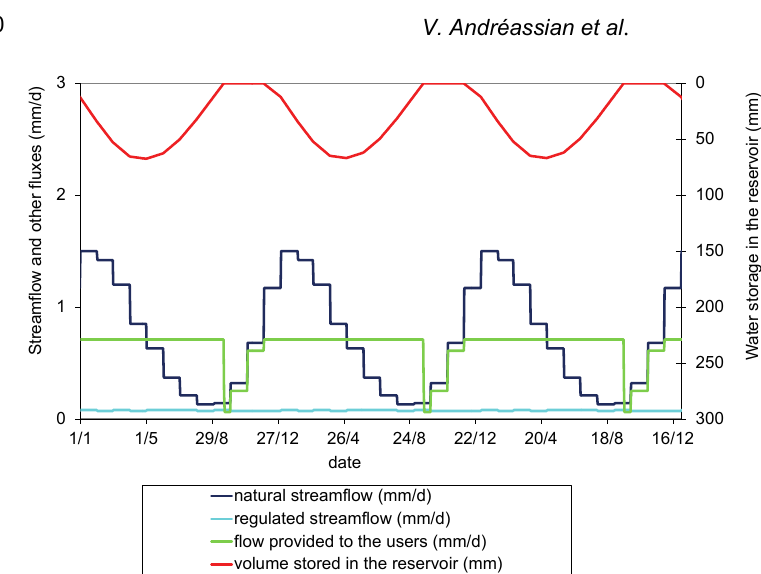
Fig. 3 Typical cycle of storage simulated in a water resource reservoir.